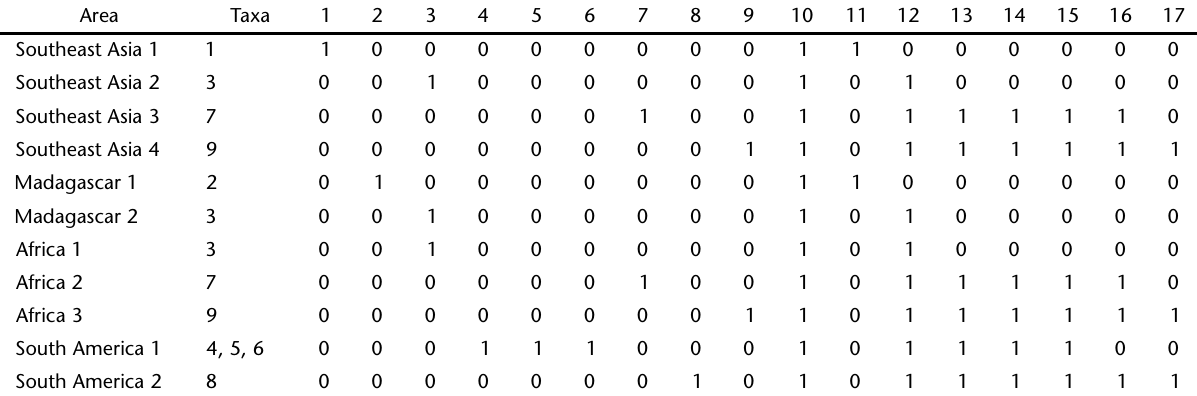
Table II. Matrix listing the geographical distribution of cuckoos subfamilies, along with the binary codes representing the phylogenetic relationships among the subfamilies. The areas were considered reticulated.